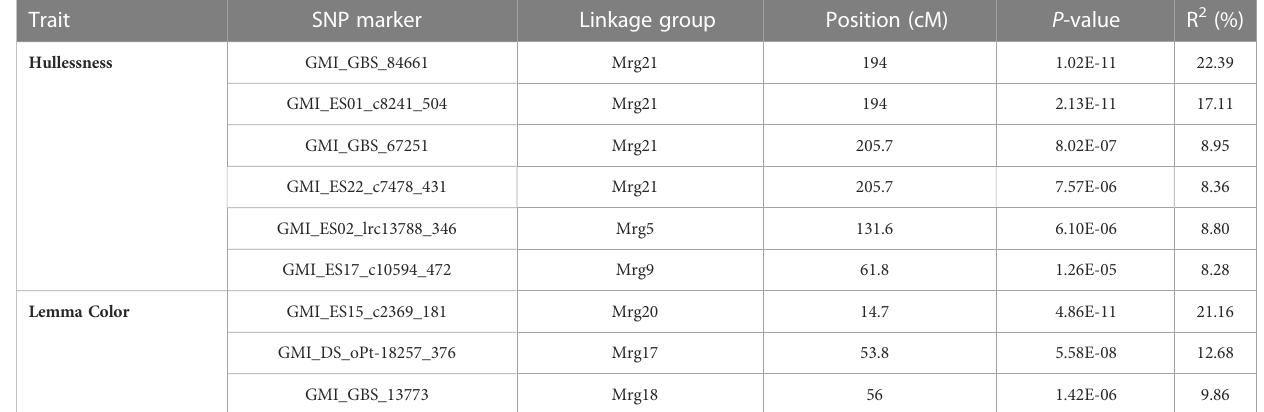
TABLE 3 Hullessness- and lemma color-associated SNPs and their positions in the oat consensus genetic map. Trait SNP marker